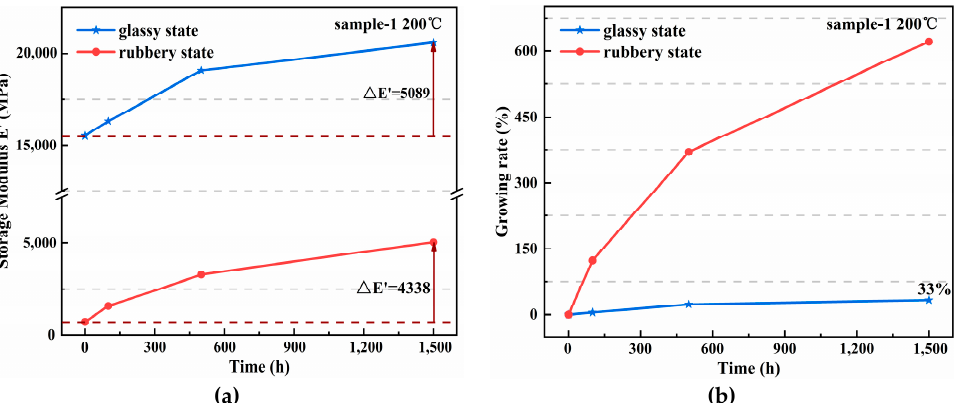
Figure 6. Increment and growing rate in the average elasticity modulus of sample 1 (temperature = 200 ◦ C). ( a ) Increment; ( b ) Growing rate.